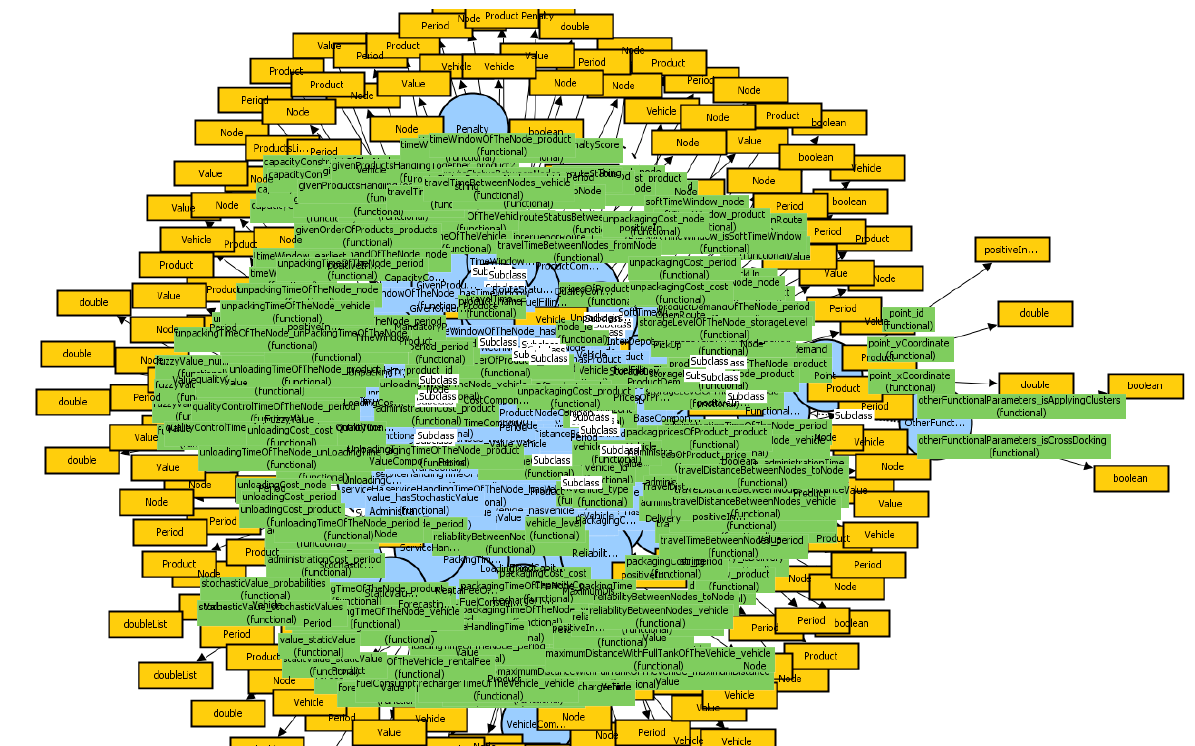
Figure 3. The VOWL representation of our ontology system.